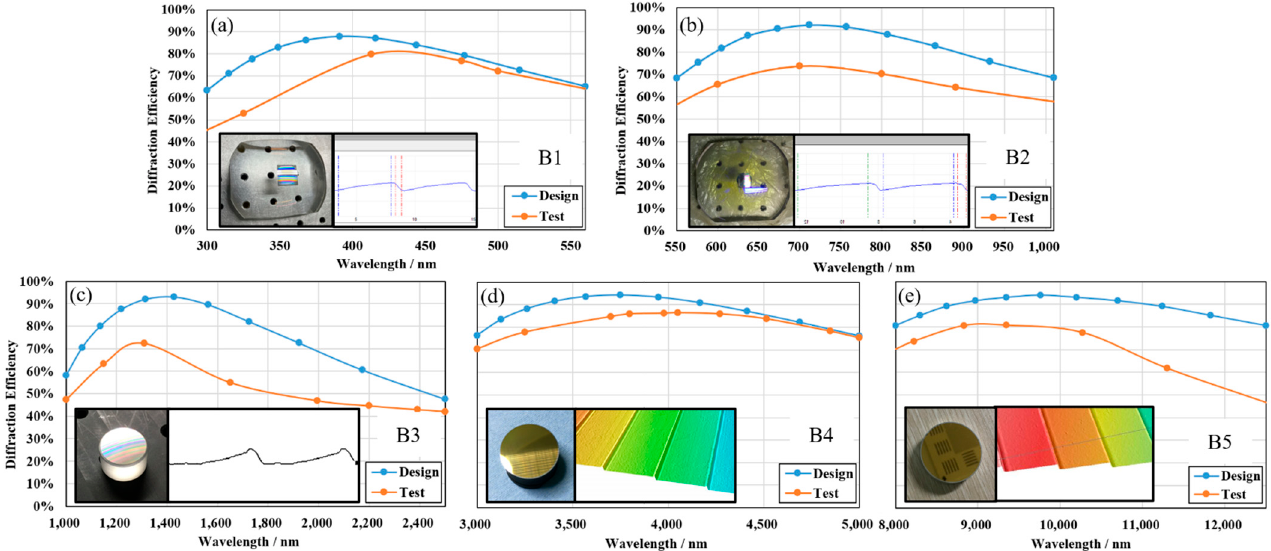
Figure 13. Convex blazed gratings and their groove shapes and diffraction efficiencies. ( a ) B1 band, groove density 312.1 lp/mm, blazed angle 3.8°; ( b ) B2 band, groove density 210.1 lp/mm, blazed groove density 312.1 lp/mm, blazed angle 3.8 ◦ ; ( b ) B2 band, groove density 210.1 lp/mm, blazed angle 4.75°; ( c ) B3 band, groove density 68.5 lp/mm, blazed angle 3.1°; ( d ) B4 band, groove density angle 4.75 ◦ ; ( c ) B3 band, groove density 68.5 lp/mm, blazed angle 3.1 ◦ ; ( d ) B4 band, groove density 19.1 lp/mm, blazed angle 2.8°; ( e ) B5 band, groove density 8.8 lp/mm, blazed angle 2.8°. 19.1 lp/mm, blazed angle 2.8 ◦ ; ( e ) B5 band, groove density 8.8 lp/mm, blazed angle 2.8 ◦